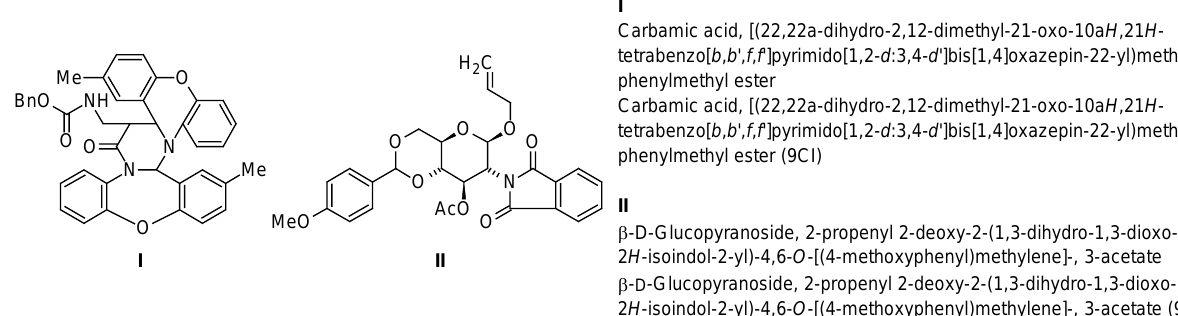
Figure 4 . Two impressive examples of generated Index names (ACD/Name) that are identical to the officially registered ones (CAS; CI ... collective